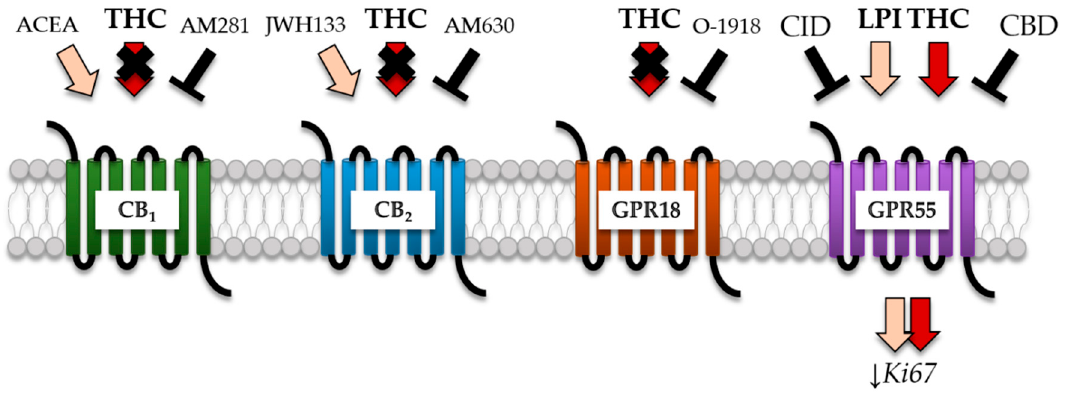
Figure 8. Proposed model for action of THC to modify Ki67 fractions in the considered GBM cells. GPR55 was identified as a potential receptor for the anti-Ki67 action of THC in human patient-derived GBM cells by systematically investigating the impact of different receptor-specific antagonists on THC acting. Despite the fact that AM281 (CB 1 -antagonist) and AM630 (CB 2 -antagonist) diminished the effects of ACEA (CB 1 -agonist) and JWH133 (CB 2 -agonist), both were not able to inhibit THC, indicating a CB 1 /CB 2 -independent mechanism. Furthermore, THC effect remained unaffected after application of O-1918 (GPR18-antagonist). Finally, CID and CBD are described as antagonists for GPR55 and indeed exerted antagonist activity in presence of THC, suggesting a GPR55-dependent signaling. Similar data were obtained after the stimulation with LPI (GPR55-agonist), confirming the participation of GPR55 in this process.